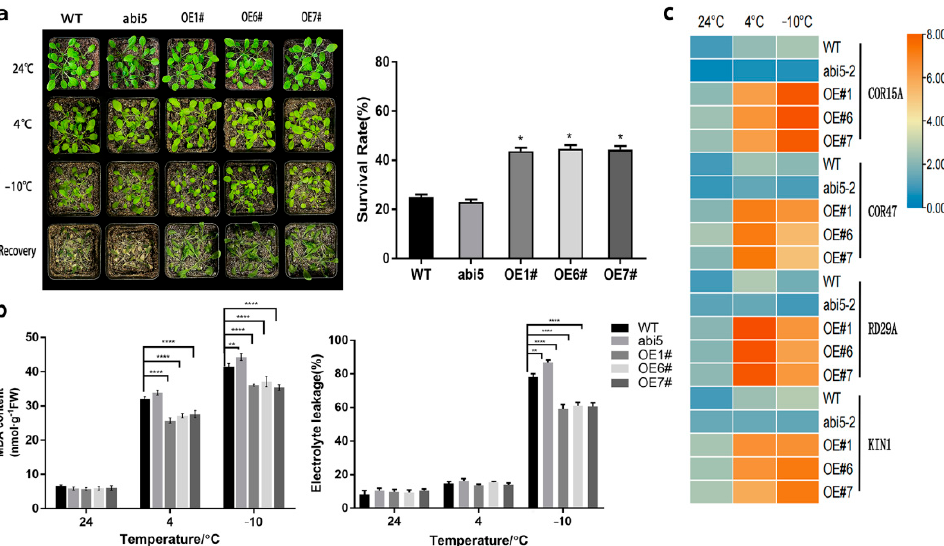
Figure 8. Analysis of cold resistance and expression of key stress response genes in transgenic plants. ( a ) Phenotype and survival rate of Arabidopsis lines under freezing stress. ( b ) MDA content and electrolyte leakage were measured. ( c ) Heat maps of stress response genes expression at 24 ◦ C, 4 ◦ C and − 10 ◦ C in different plant lines, respectively. All values in the figure are mean ± SD ( n = 3), p values (versus WT) were corrected with ANOVA, * p < 0.05, ** p < 0.01, and **** p < 0.0001.